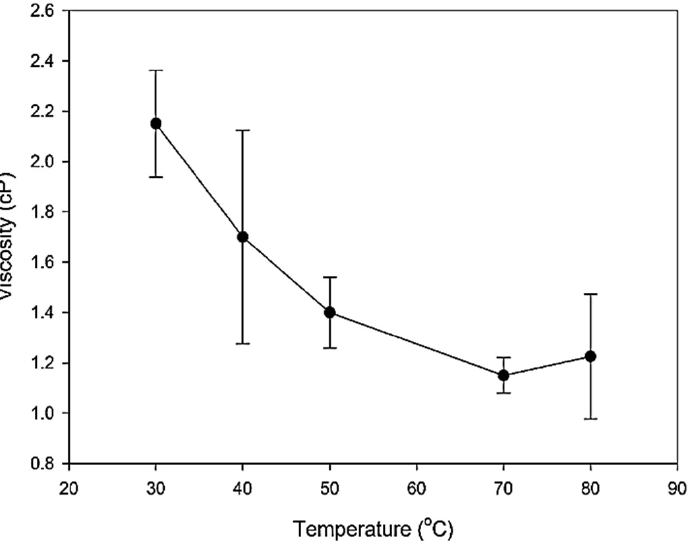
Figure 11. Variation of error of dynamic viscosity of experimental and ASHRAE Standard data of base fluid.